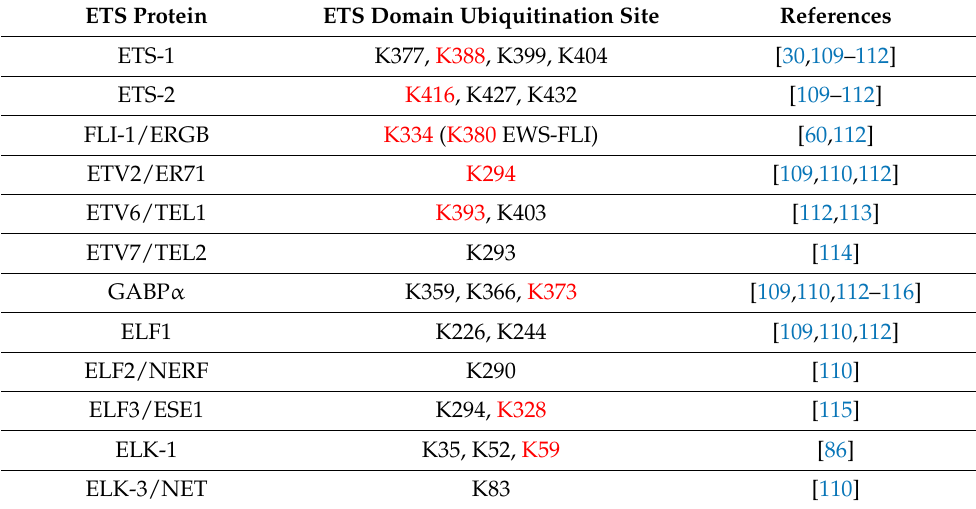
Table 2. ETS-domain lysines identified as ubiquitination sites from targeted and large-scale proteomic datasets and/or mutational analysis (human-produced with use of PhosphoSitePlus). Highlighted in red is the conserved α 3 helix lysine found to be a target in multiple ETS